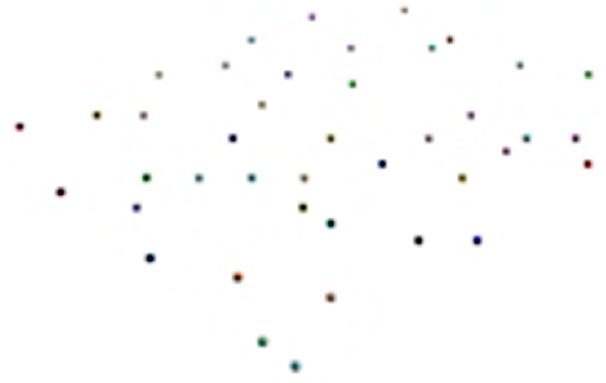
Figure 9. Decomposed geometry containing point